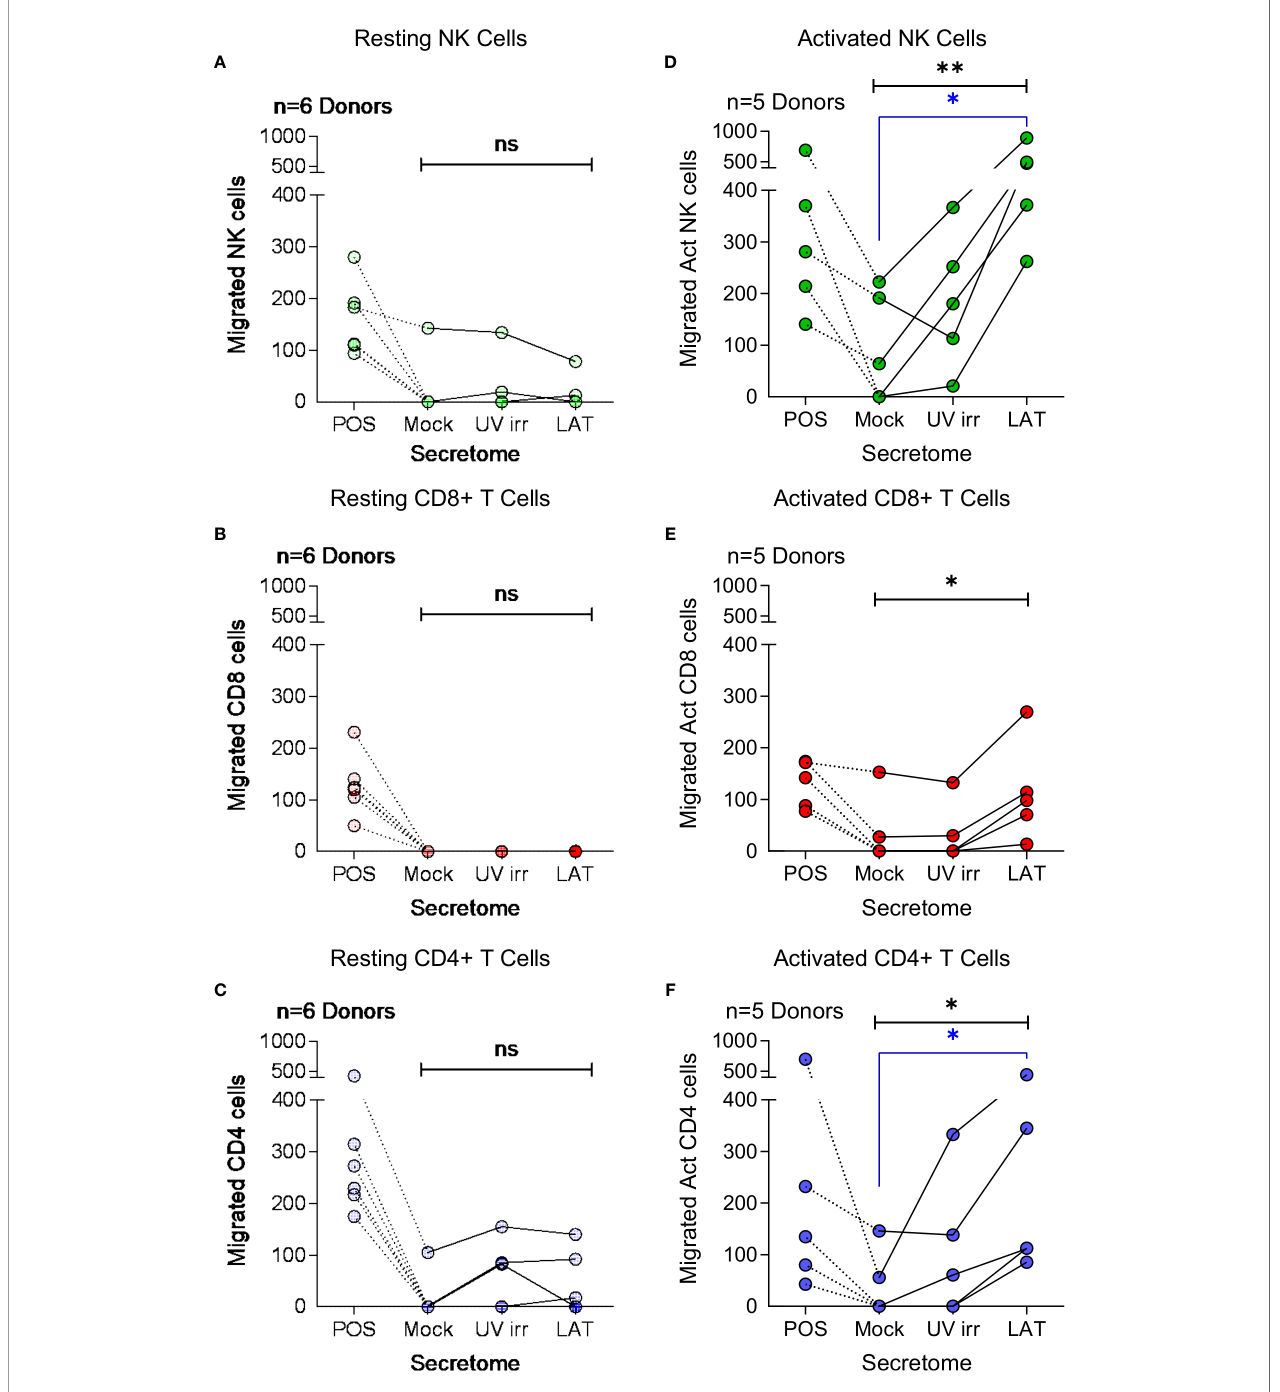
FIGURE 3 | Migration of activated immune cell subsets in response to monocyte latent secretome. Transwell migration assays were performed in response to positive control, Mock, UV irradiated (UV irr) and Latent infected (LAT) CD14+ monocyte secretomes from day 7 harvest in multiple donors (indicated on each graph). Shown are the results from migration assays performed with resting NK cells – light green (A) , CD8+ T cells – light red (B) and CD4+ T cells – light blue (C) subsets. Following polyclonal activation (Act) transwell migration assays were performed with NK cells – dark green (D) , CD8+ T cells – dark red (E) and CD4+ T cells – dark blue (F) . All tested immune cell subsets from all donors migrated to the positive control, but there was only signi fi cant migration of the activated cell subsets (Friedman ’ s 1 way ANOVA – results indicated in black on graphs; Act NK p=0.0085**, Act CD8 p=0.0123* and Act CD4 p=0.0123*, non signi fi cant (ns) results are also indicated) to the latent infected secretomes. Activated NK cells and CD4+ T cells signi fi cantly migrated to the latent infected secretome (Dunn ’ s post-test shown in blue on graphs; NK p=0.0133* and CD4